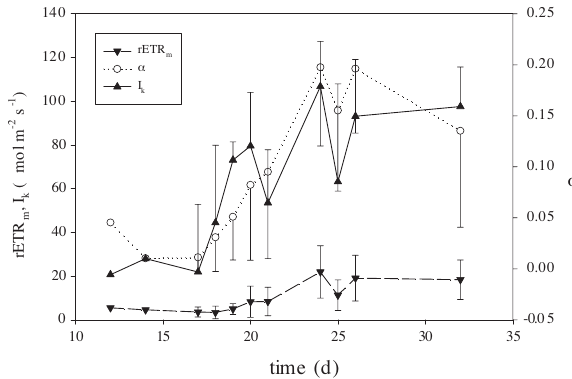
F IG . 2. – Development of parameters of photosynthesis curves: rel- ative electron transport rate (rETRm, relative units), α and satura- tion irradiance (Ik, µmol m -2 s -1 ) of Cymodocea nodosa plants grown in high light during a recovery experiment after a four month dark period. Error bars represent 1 SD (n = 7). T ABLE 1. – Average estimates (± 1 SD) of rETR , α and I of rapid m k light curves fitted to the equation of Jassby and Platt (1980) of Cymodocea nodosa plants recovering from a 4 month dark period compared with those collected from two sites in southern